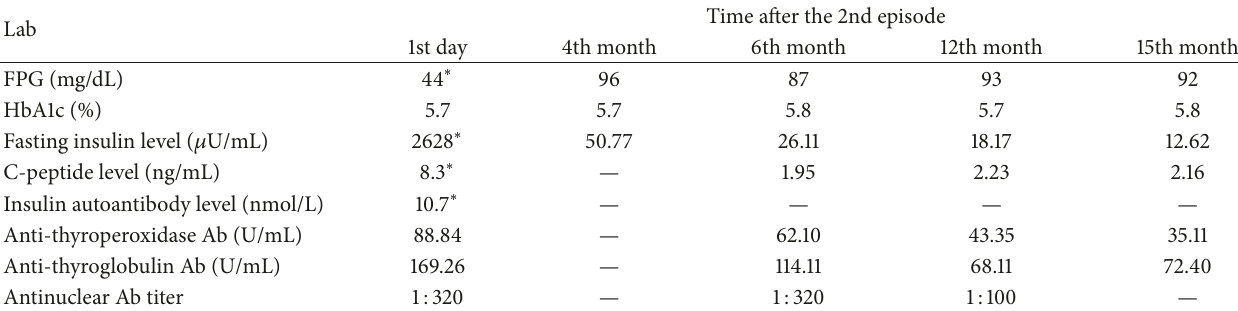
Table 1: Laboratory investigation during initial and subsequent follow-up